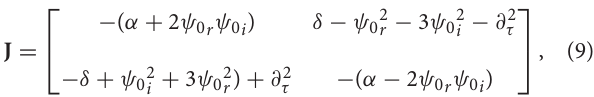
FIGURE 3 | Evolution of the driven dissipative non-linear Schrödinger obtained by integration of Equation (3) for α correspond to the local largest Lyapunov exponent, while the red circles are the local maxima detected. The gray bars mark the location of these local maxima.